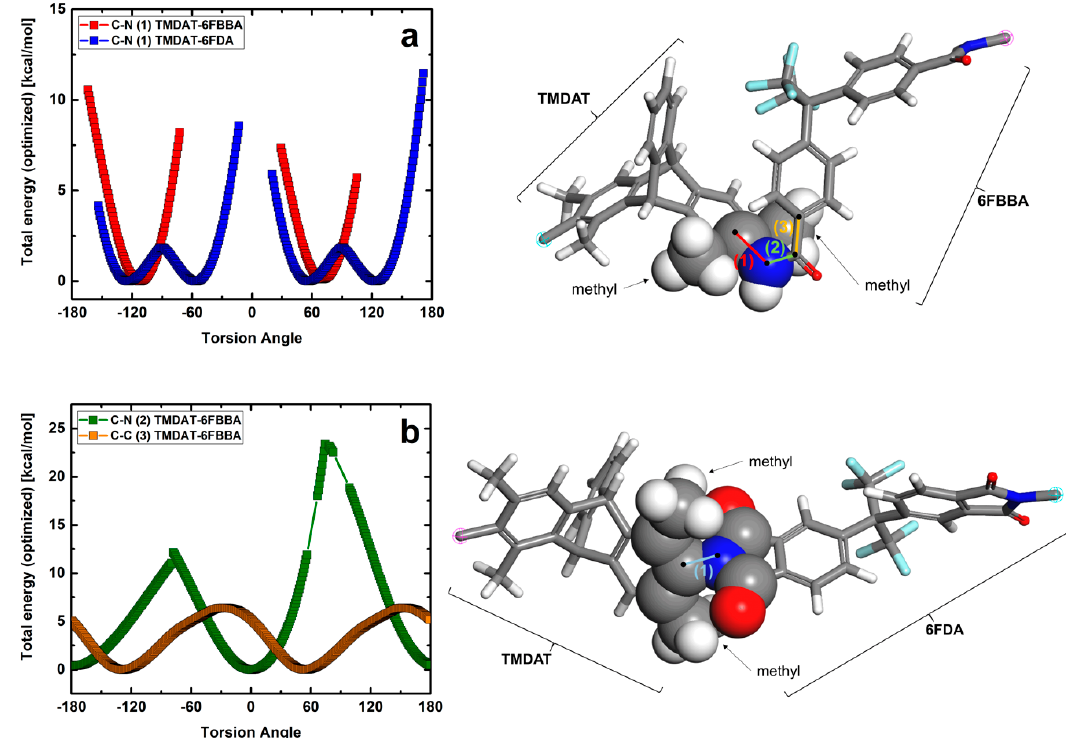
Figure 5. Torsion energy vs. torsion angle for the amide group of the 6FBBA-TMDAT (three dihedral angles) and for the single dihedral angle of the imide group of the 6FDA-TMDAT (polyimide). Rotation freedom around: ( a ) The C–N (1) bond of both 6FBBA-TMDAT and 6FDA-TMDAT; ( b ) for the remaining C–N (2) and C–C (3) bonds of the amide group of the polyamide.